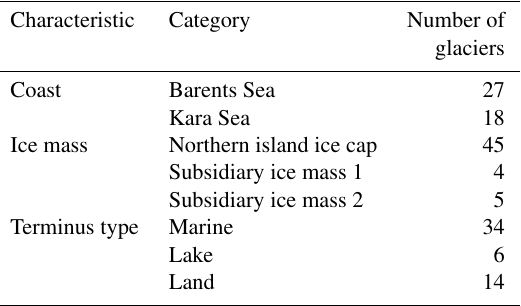
Table 1. Number of outlet glaciers contained within each category used to assess spatial variations in retreat rate, specifically coast, ice mass, and terminus